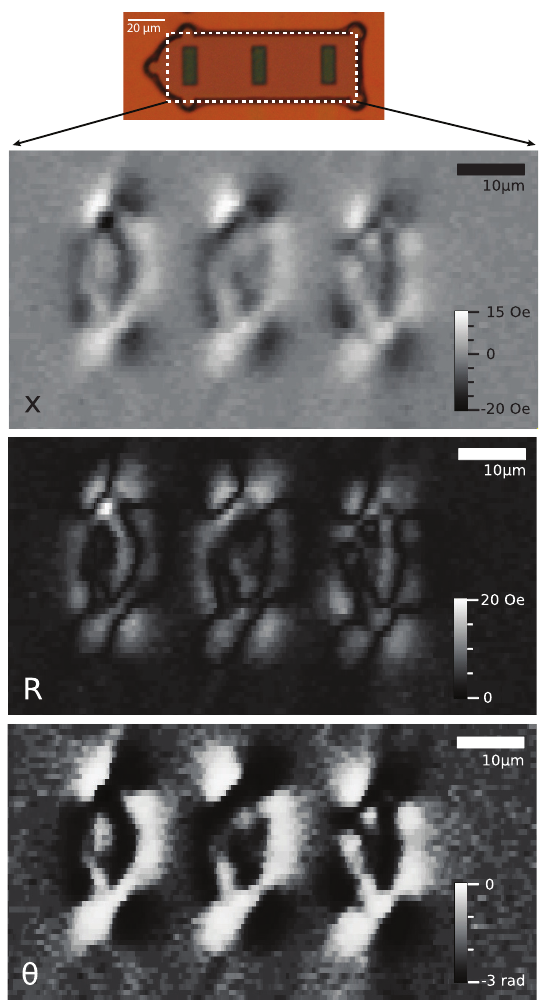
Figure 7. The data obtained when scanning a TMR sensor a few microns below a three-bit tag with equal aspect ratios (1:2.5) and thereby measuring the stray field in a 50 × 90 µ m 2 area. The sensitive axis is vertical as presented in the figure. The images are obtained from the real component ( x ), the amplitude ( R ) and the phase ( θ ) of the signal. Frequency: 233 Hz, time-constant: 50 ms, scan speed: 40 µ